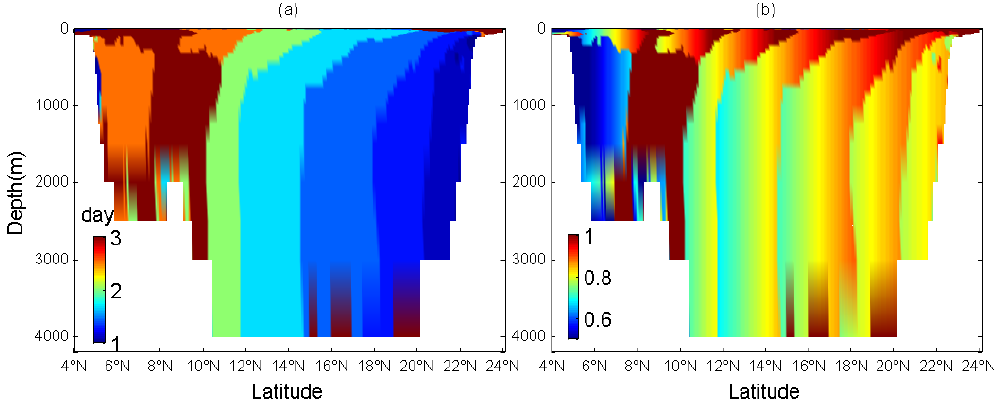
Figure 3. (a) The period corresponding to the power peak of the SCSMOC, which passes 95% significance; (b) the ratio of the peak period of the SCSMOC to the local inertial